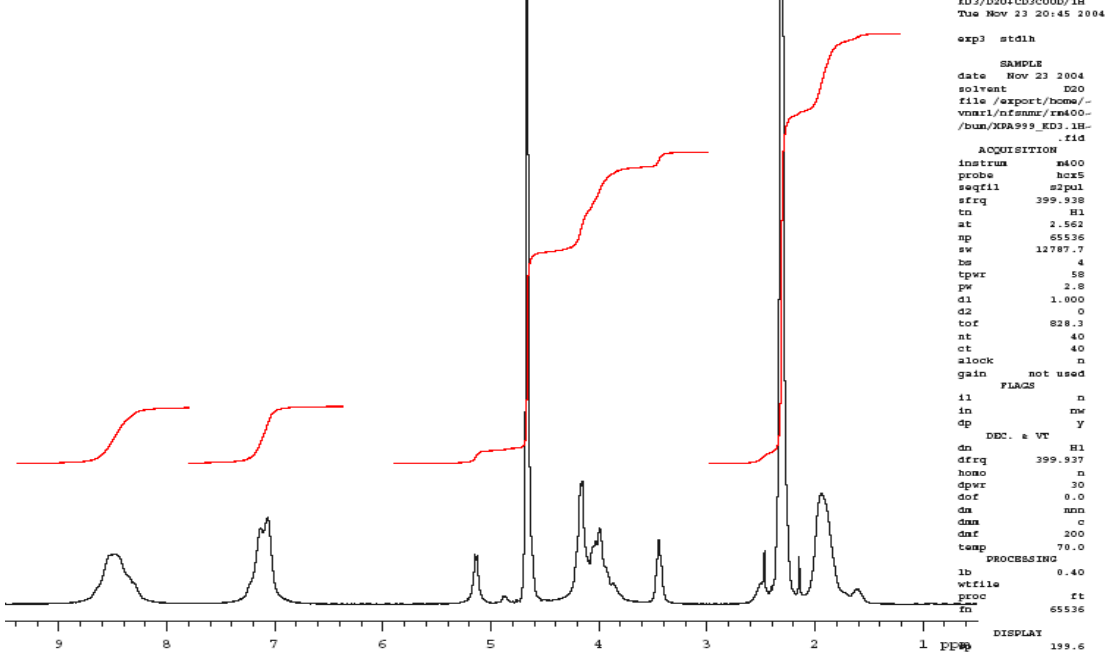
Figure 2. 1 H-NMR spectrum of 80% VP grafted